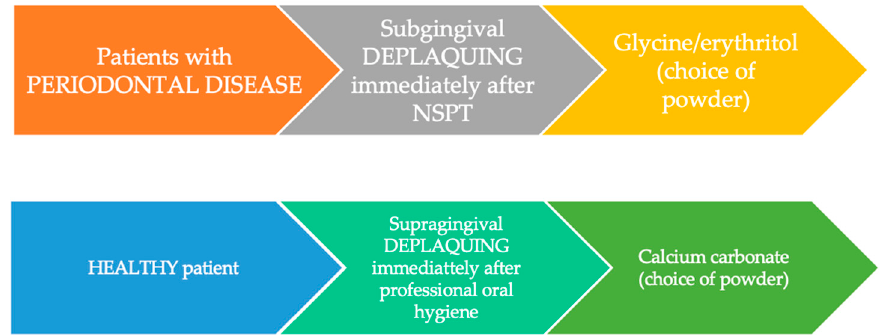
Figure 6. How to choose the type of powder, based on the oral health of the patient. NSPT: nonsurgical periodontal therapy.